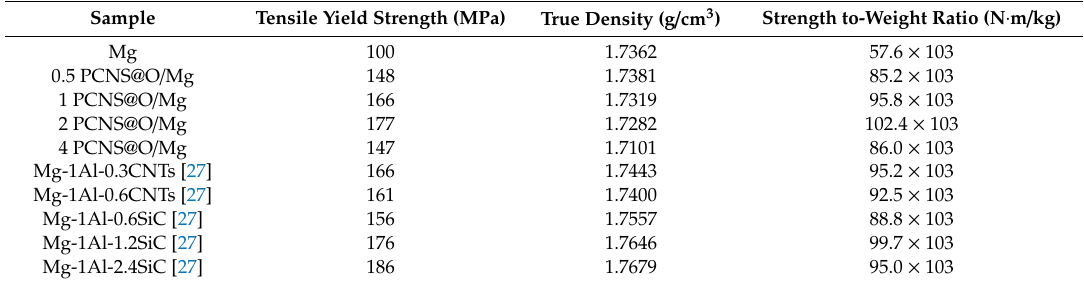
Table 4. Strength-to weight ratio of PCNS-reinforced Mg